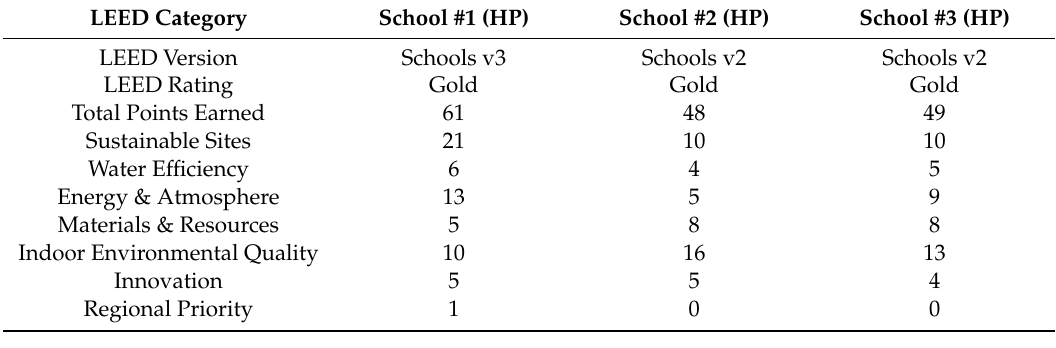
Table 3. Detailed LEED Credits by School Including (a) Total Credits by Category and (b) Specific Credits Earned in the IEQ